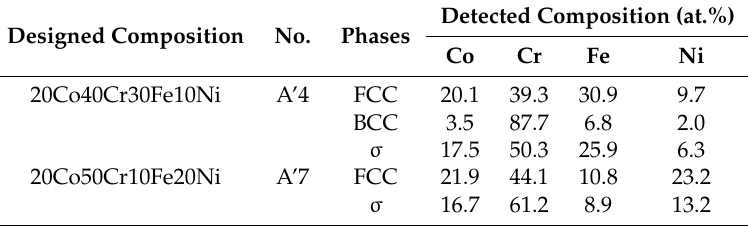
Table 1. The detected chemical composition of the alloys A’4 (20Co40Cr30Fe10Ni) and A’7 (20Co50Cr10Fe20Ni) after being annealed at 1000 °C for 30 days. Designed